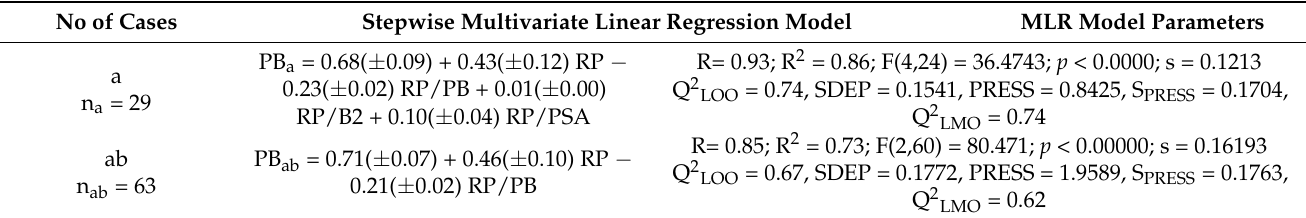
Table 4. MLR models for acidic drugs (a) and combined group of APIs (ab) using RP TLC retention data. No of Cases Stepwise Multivariate Linear Regression Model